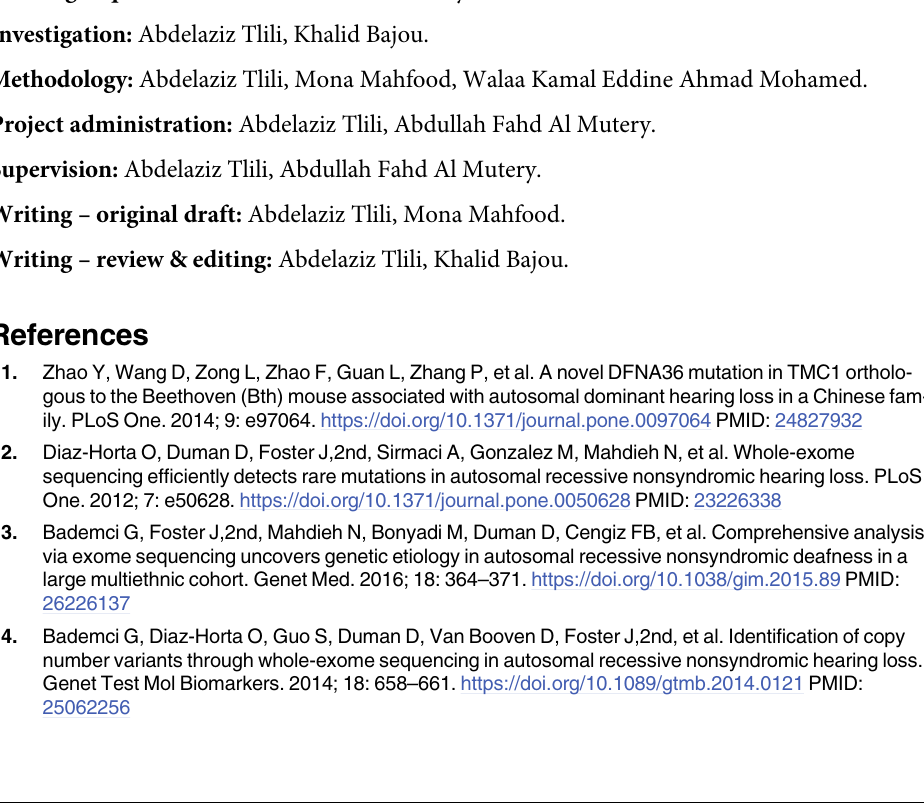
S1 Table. Clinical assessment of affected